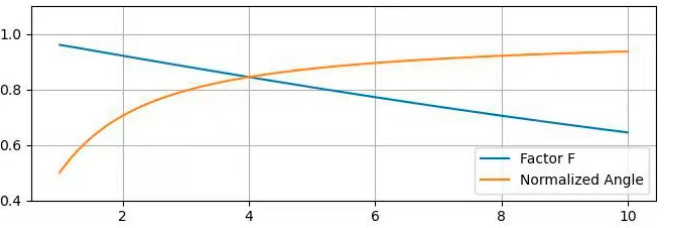
Figure 9. Illustration of the factor F and the normalized angle with α = 1. The horizontal axis represents the aspect ratio. The vertical axis represents the value of the factor F and the normalized angle.